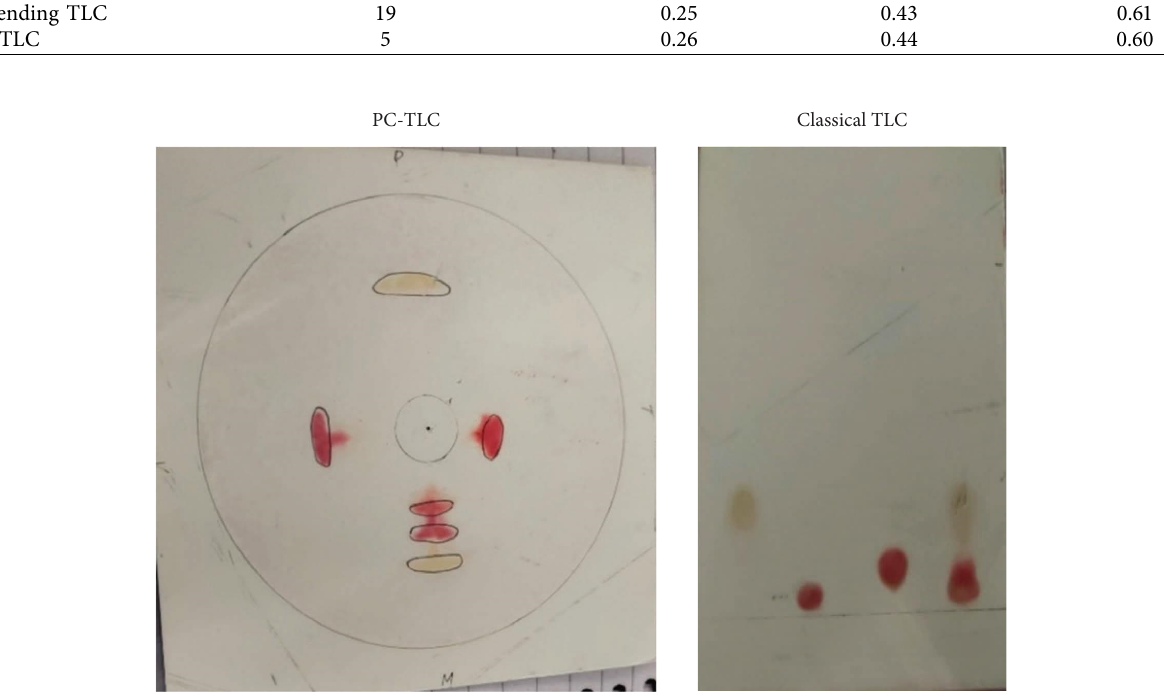
Figure 2: Amino acid separation by classical and pressurized